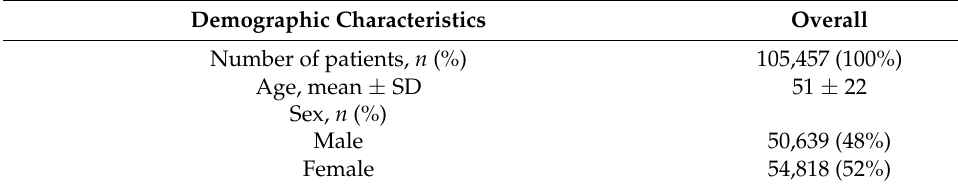
Table 1. Characteristics of the study